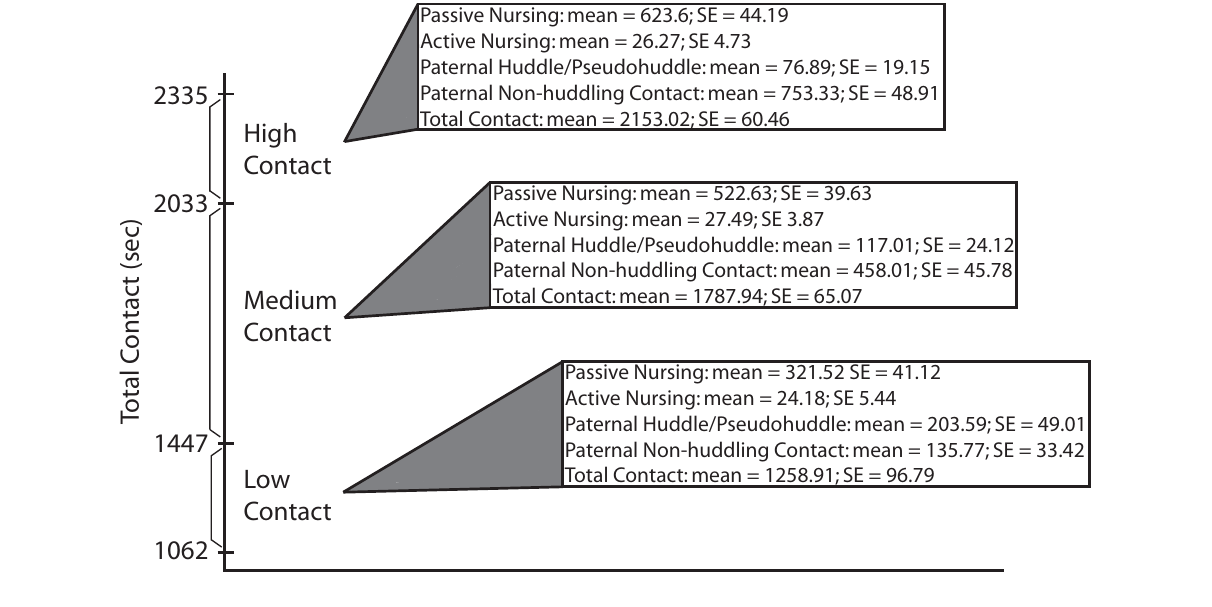
significantly different between high- and low-contact breeder pairs during early parental care observations of subject offspring (data presented in Figure 2